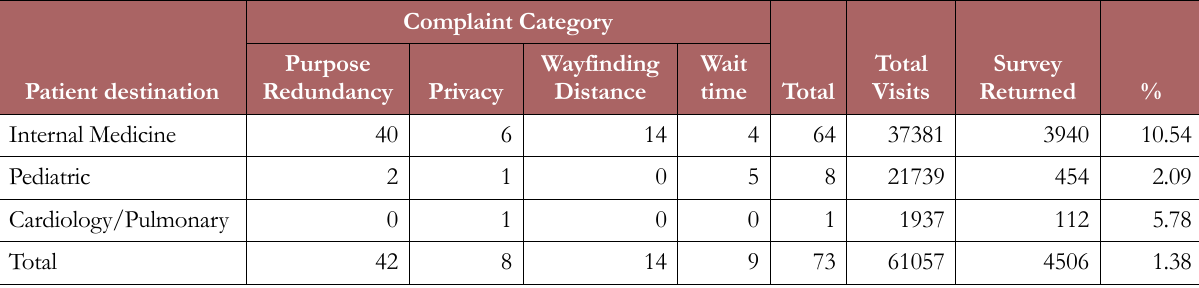
Table 1. Matrix of complaints about central registration